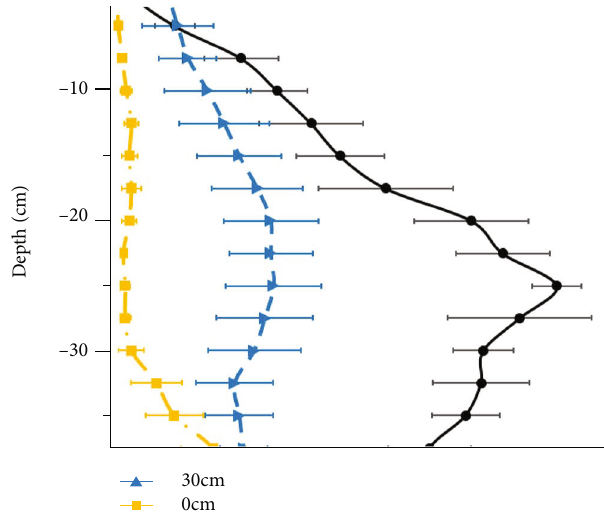
Figure 17: Variation in soil fi rmness with depth before and after